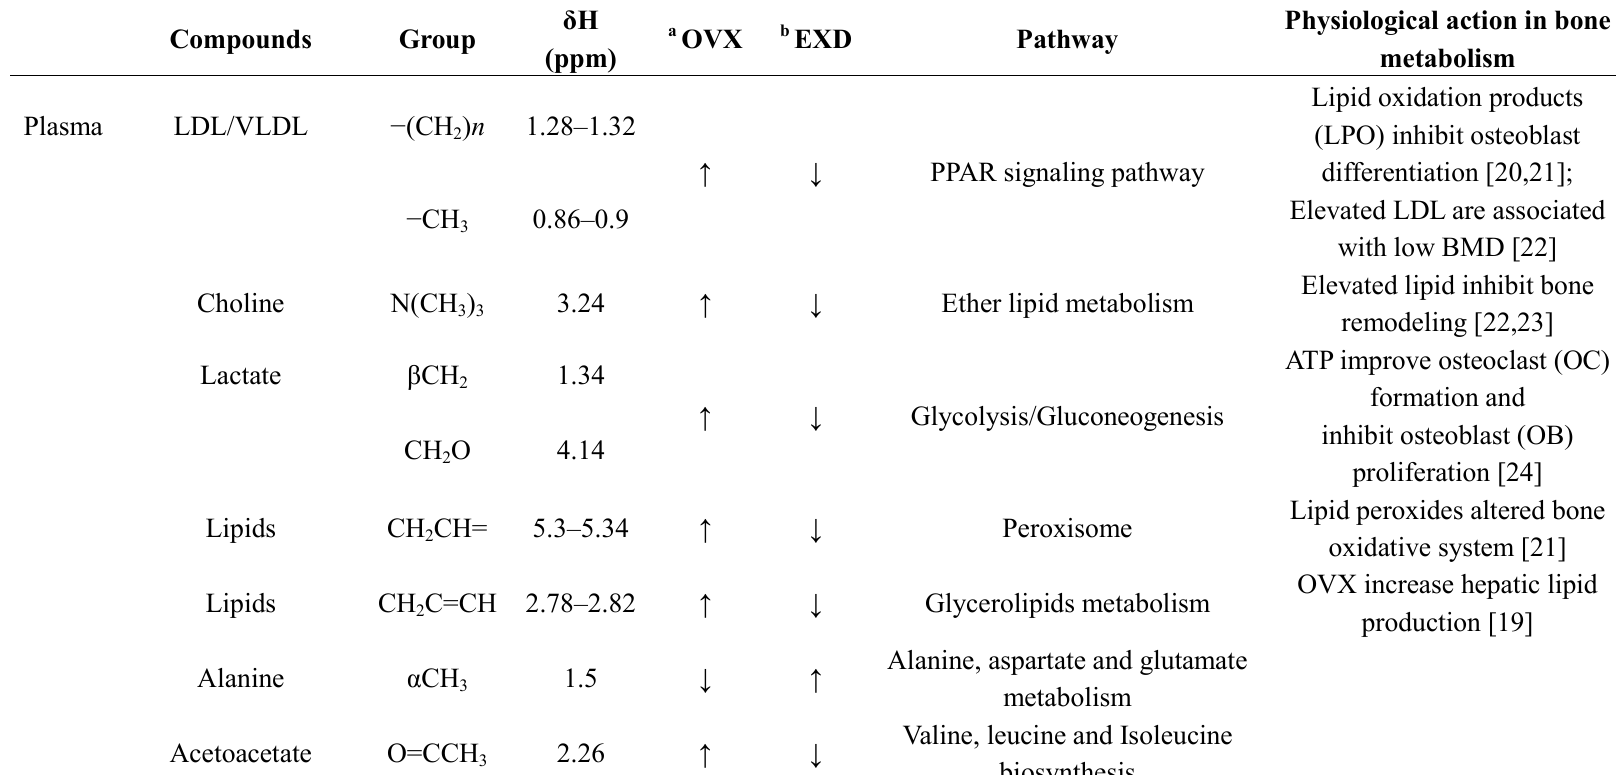
Table 3. The identified biomarkers in ovariectomized osteoporotic rats and the reverse effects of EXD.